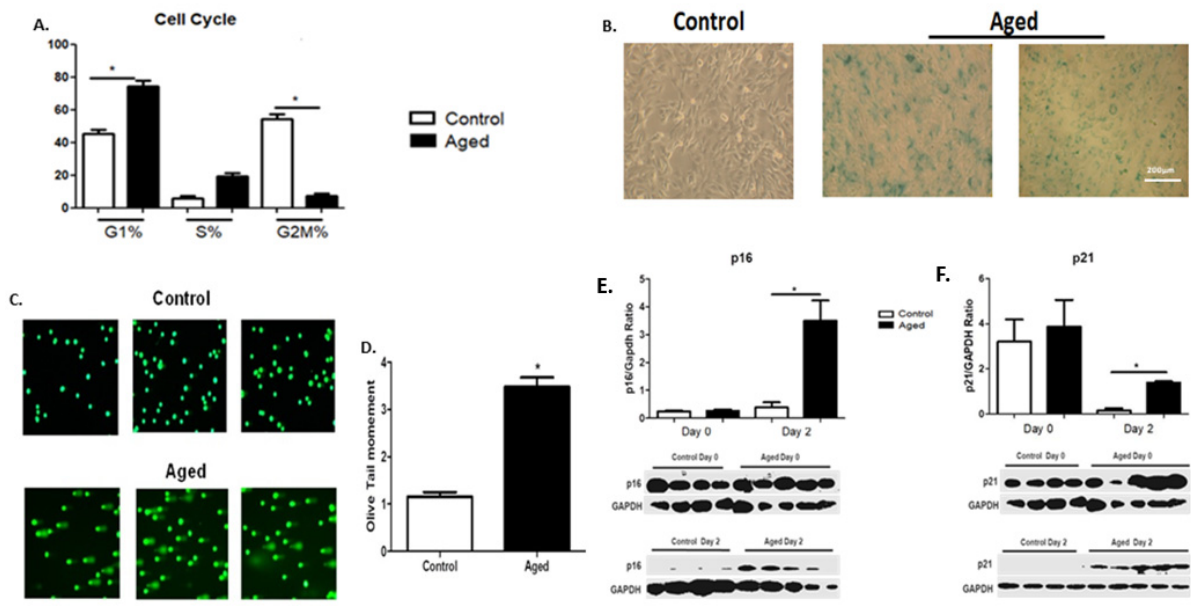
Figure 1. ( A ) Effects of myoblast senescence on cell cycle progression. Percentages of cells in each phase arerepresented for the control and aged myoblasts. In contrast to the controls, the aged myoblasts exhibited an aging phenotype with an arrest of cell cycle progression, i.e., increased number of cells (%) in the G1 phase along with a reduction incell number in the G2/M phase. ( B ) Increased SA- β -gal activity as a result of myoblast aging. Representative images of the increased SA- β -gal-positive blue-green stain cells in the aged myoblast cultures. ( C ) Increased DNA damage as a result of myoblast aging. Representative alkaline comet assay images of aged myoblasts and control cells. ( D ) Quantification of the endogenous DNA damage in aged myoblasts compared to controls. ( E , F ) Effects of myoblast aging on the expression of cellular senescence-associated proteins p16 and p21. Three independent experiments were performed, and 200 cells per sample were scored. Representative Western blots and immunoblotting quantification of p16 ( E ) and p21 ( F ) expression in aged myoblasts compared to controls in the second day of their differentiation process. The expressions of the proteins were normalized to each corresponding GAPDH on the same immunoblot (Mean ± SE of 3 independent experiments performed in triplicate; * p < 0.05).